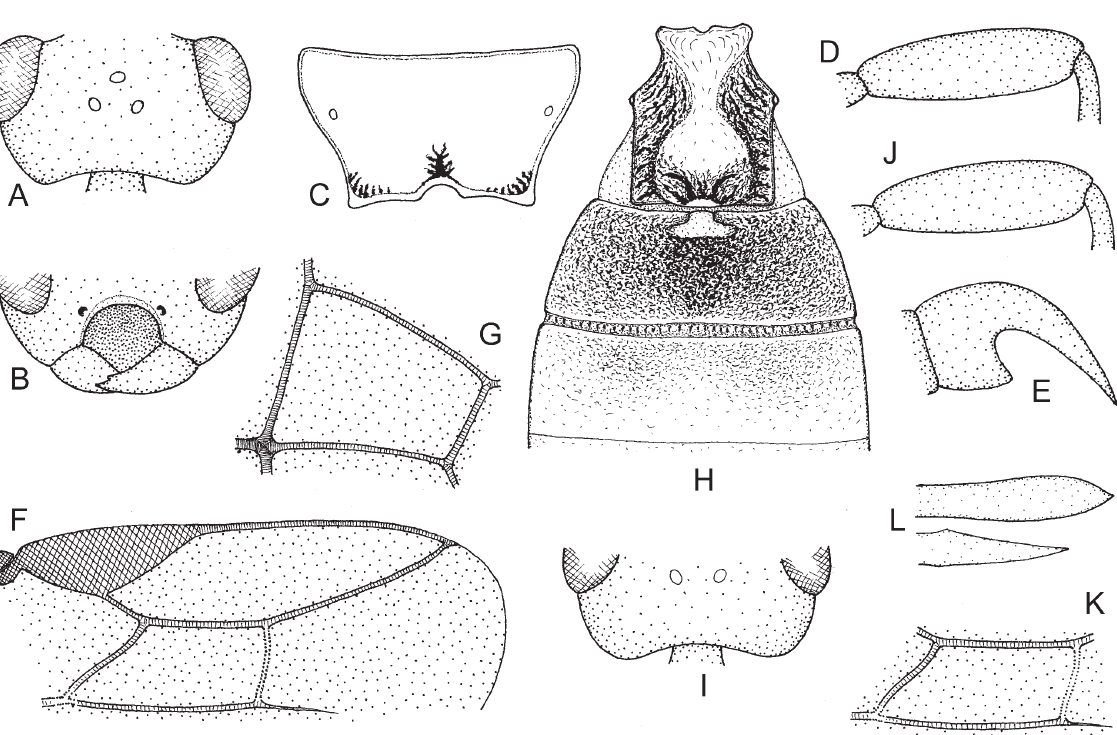
Fig. 44. Bracon ( Lucobracon ) roberti Wesmael, 1838 (A-H: ♀ holotype, I-L: ♀). A . Head in dorsal view. B . Head in frontal view. C . Propodeum. D . Hind femur. E . Claw. F . Distal part of right forewing. G . First discal cell of right forewing. H . Tergites 1-3. I . Head in dorsal view. J . Hind femur. K . Second submarginal cell. L . Posterior end of ovipositor